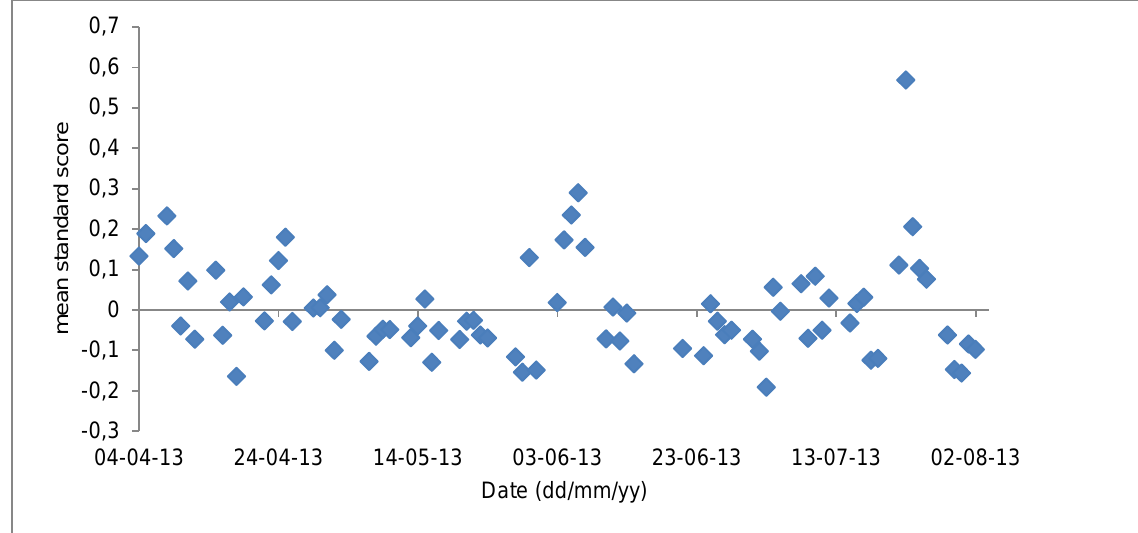
Figure 5. Mean standard score at site #11,